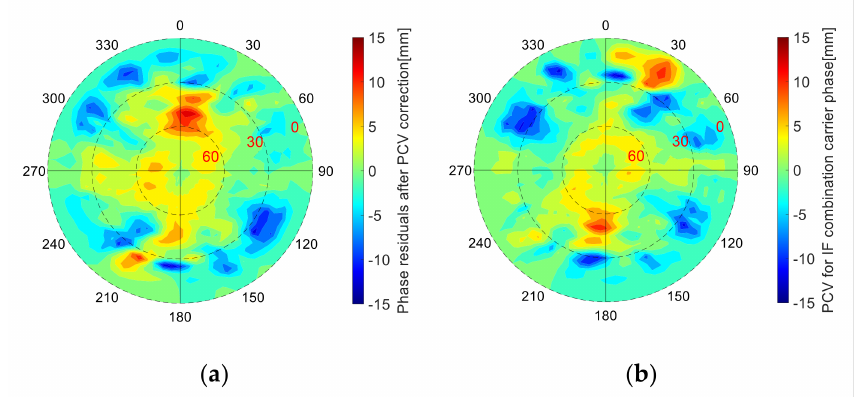
Figure 3. The 5 ◦ × 5 ◦ PCV corrections of ( a ) GRCC and ( b ) GRCD satellites based on ionosphere free carrier phase residuals from SD AR